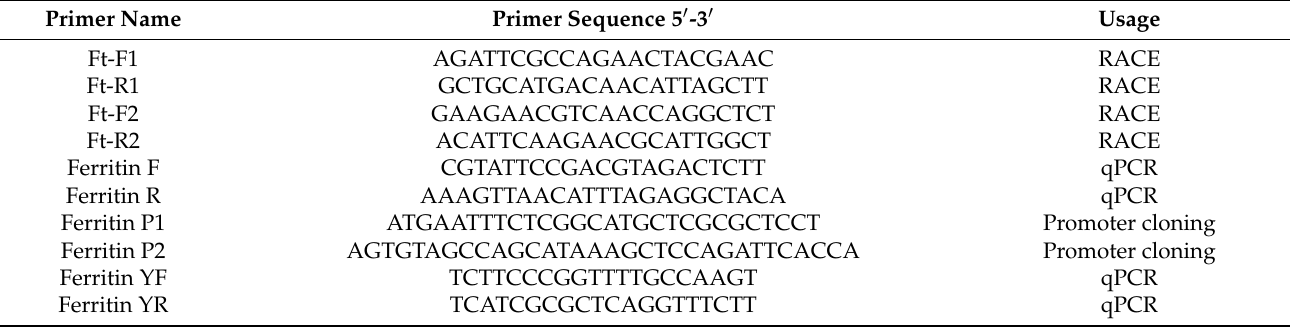
Table 1. The primers used in cDNA and promoter cloning, qPCR, and